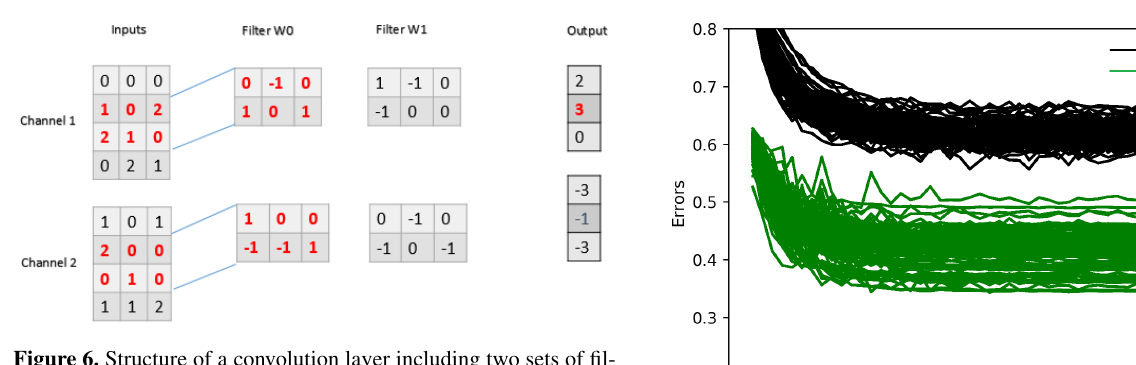
Figure 6. Structure of a convolution layer including two sets of fil- ters.